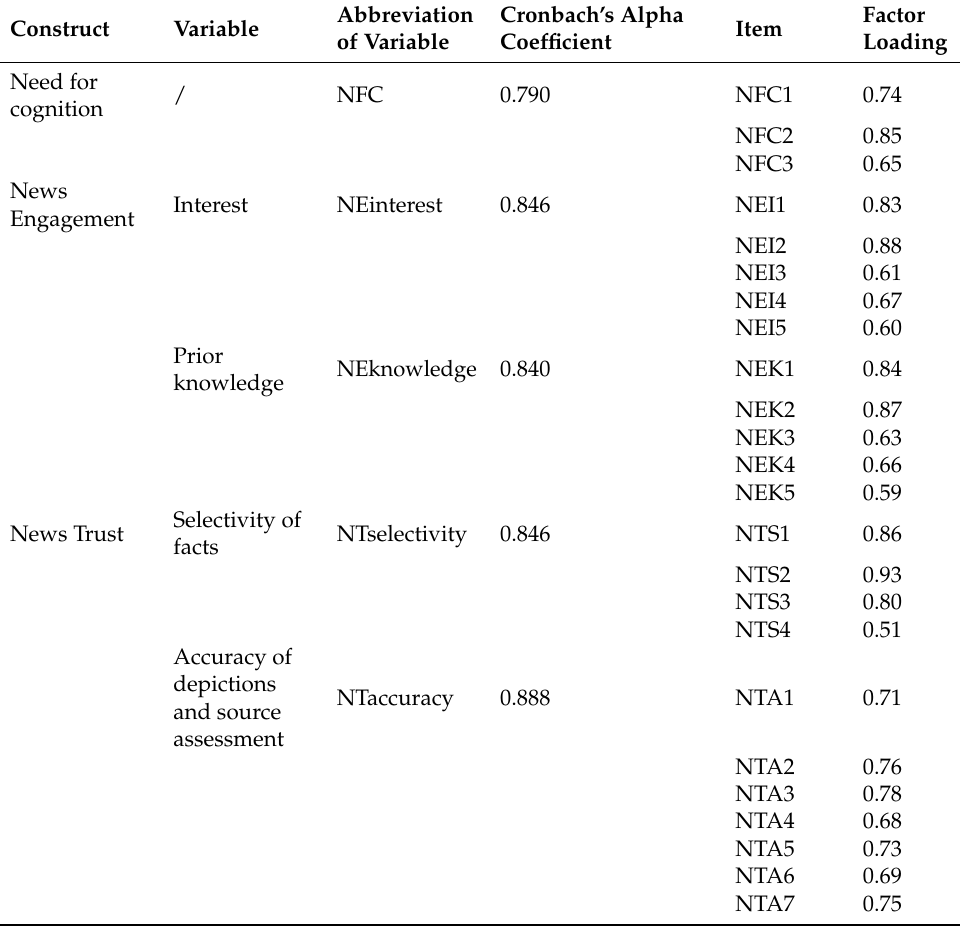
Table 2. Reliability of variables and factor loadings for the